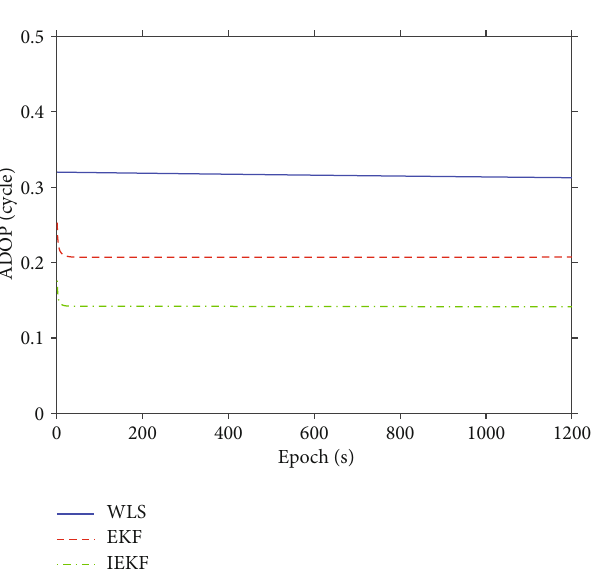
Figure 6: The ADOP values of various algorithms (Data 1).